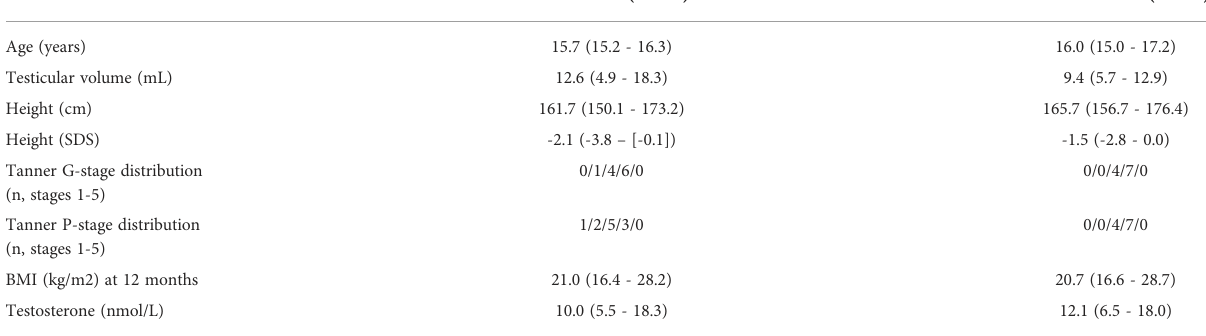
Table 1b: Follow-up data at 12 months (mean and